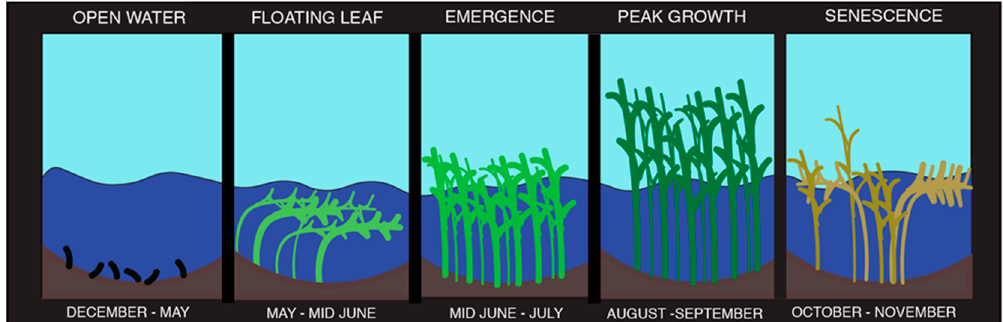
Figure 1. The annual life cycle of northern wildrice.